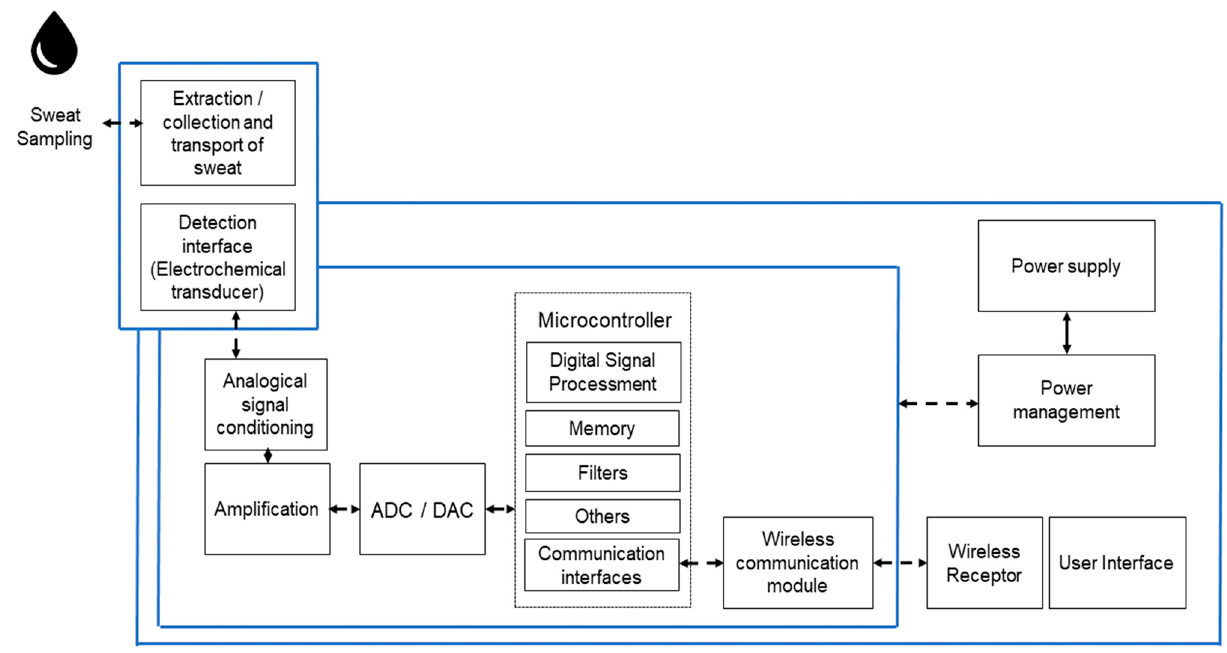
Figure 10. Fundamental blocks of a wearable electrochemical sweat sensor.